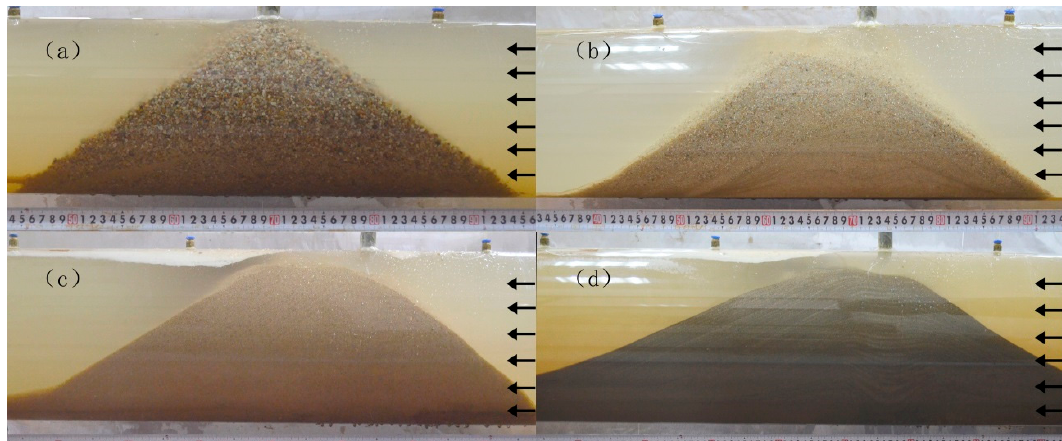
Figure 3. Deposition of aggregate with four different particle sizes (arrows represent water flow).